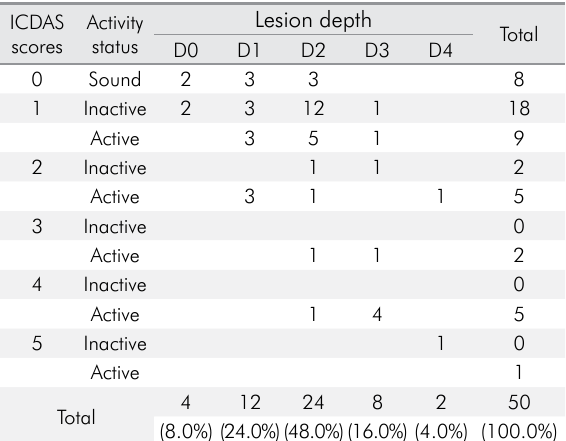
Table 2. Distribution among scores obtained with the International Caries Detection and Assessment System (ICDAS) and caries lesions activity status and the lesions depth evaluated through histological assessment